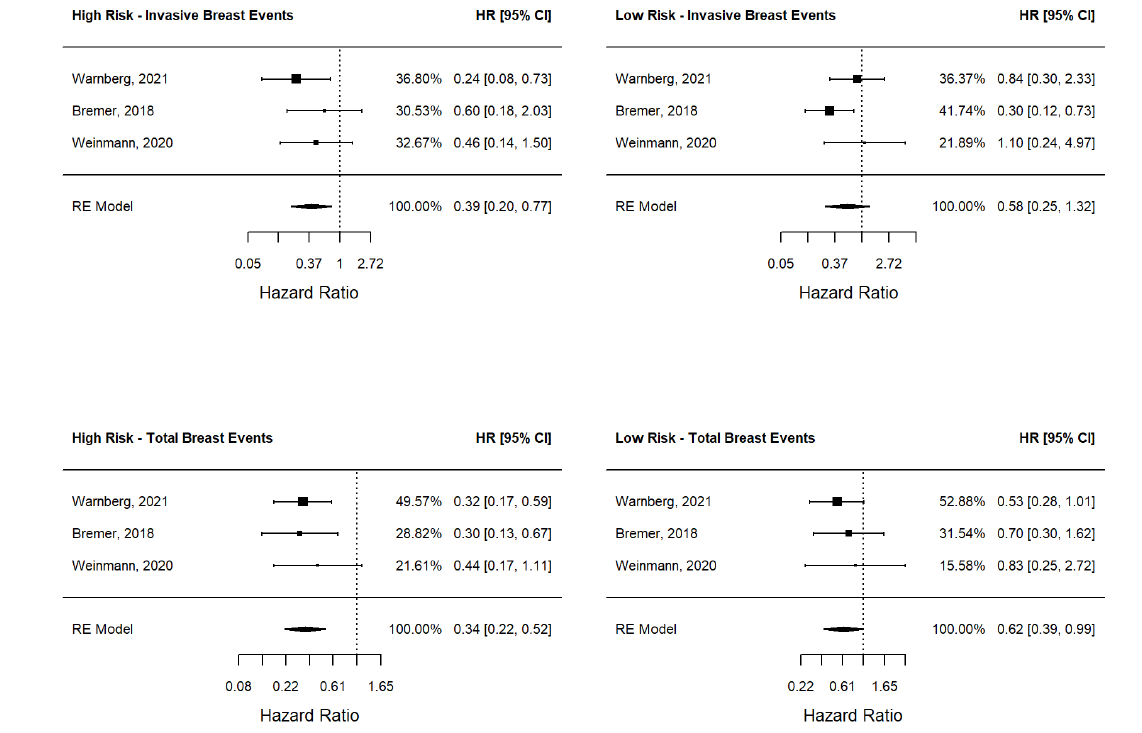
Figure 2. Meta-analysis of DCISionRT studies: Forest plots. Legend: HR = hazard ratio; 95%CI = 95% confidence interval; RE model = random effect model; Percentages represent the individual weight of